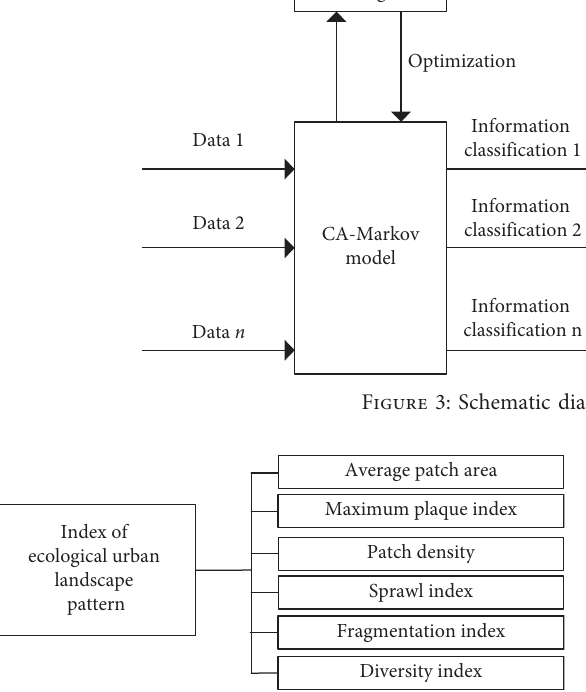
Figure 4: Index structure diagram of ecological urban landscape pattern.